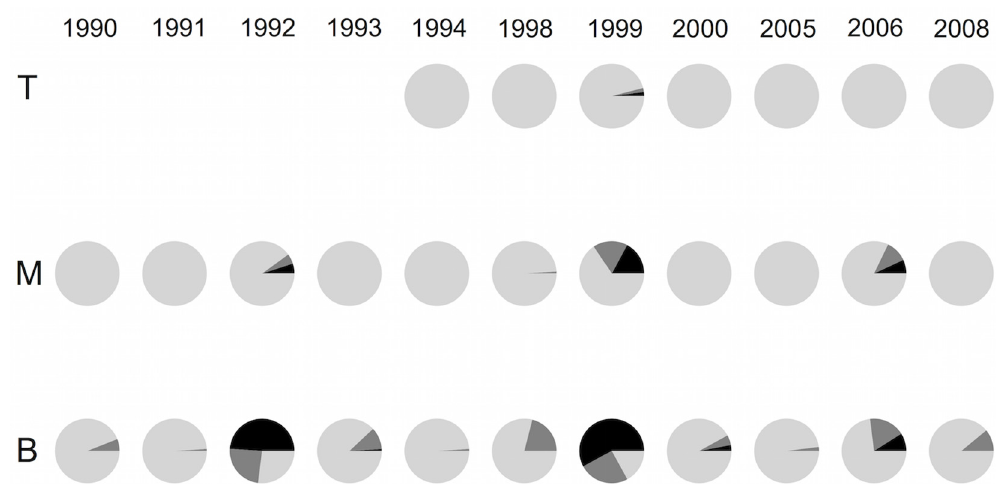
Fig 4. Volunteer stem analysis. The percentage of total eighth sections showing absent (black), pinching (medium gray), or fully present (light gray) rings for the discs along different heights of the stem of Volunteer trees. The basal (B), middle (M), and top (T) sections are shown. Fewer than six trees extended before 1994 for the top disc sample, therefore we truncated the analysis at that year for the top stem sample only. All of the basal and middle sections extended prior to